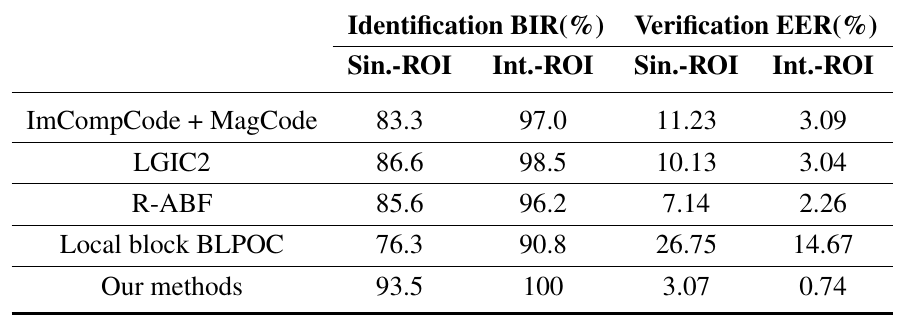
Figure 11. The ROC curves of all methods for single ROI recognition based on DB-1. Table 2. Comparison of the five methods based on DB-2. Note that “Sin.-ROI” and “Int.-ROI” are the abbreviations of single ROI and integrated ROI recognition, respectively. Identification